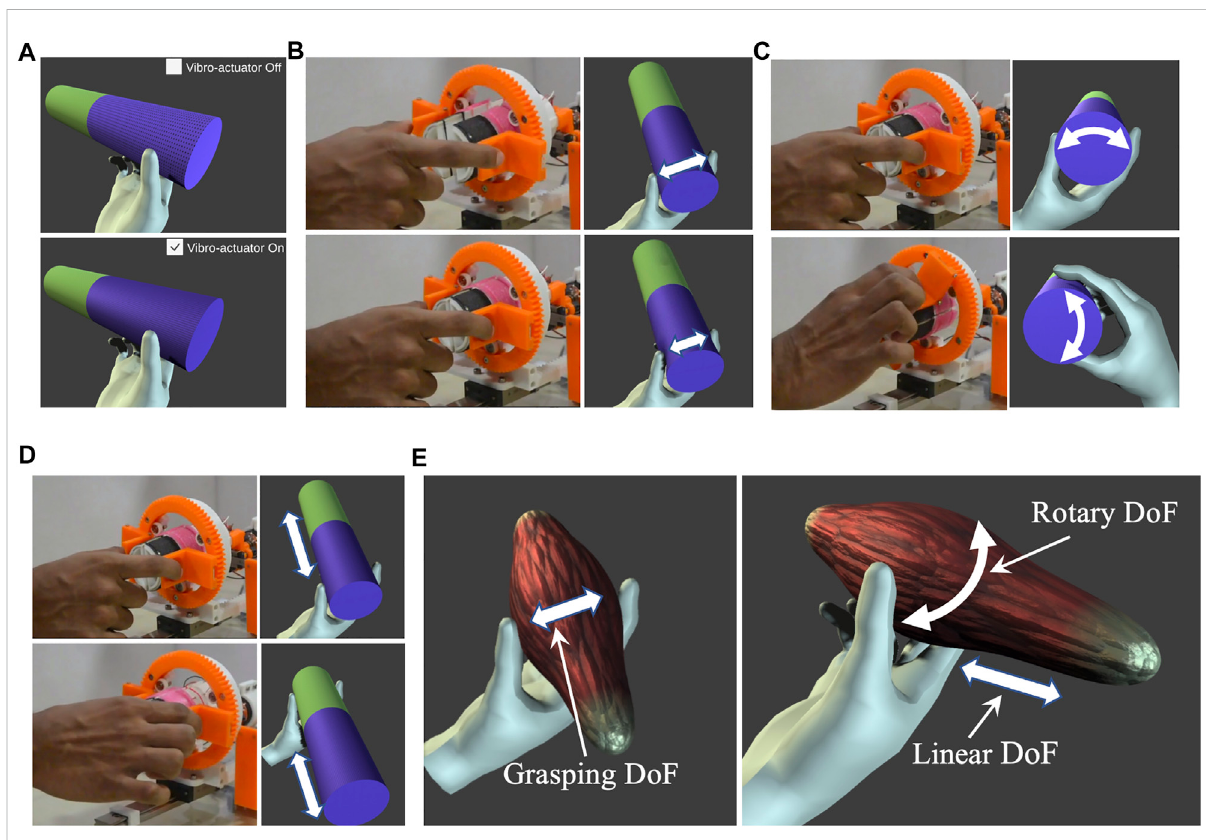
FIGURE 11 A cylindrical virtual object is created and rendered to the user to highlight the attributes of the proposed haptic grasper. (A) Textural feedback with/without Vibro-actuator. Three degrees of freedom (DoF) of the cylindrical object are provided to the user. (B) Grasping DoF (C) Rotary DoF (D) Linear DoF. (E) A telesurgical application demo isalso rendered to theuser allowing him to explore thevirtual muscle characteristics such as texture, shape, and stiffness. The double-headed arrows represent the grasper ’ s direction of